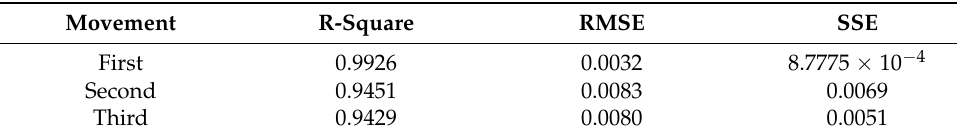
Table 1. Modeling criteria of the three movements.